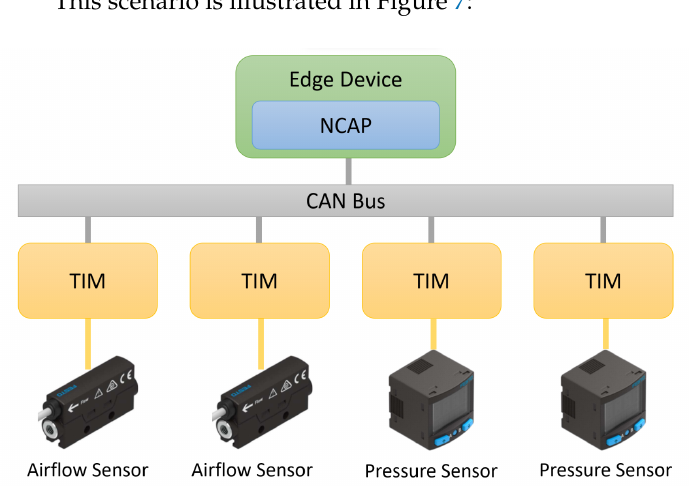
Figure 7. Test Scenario.